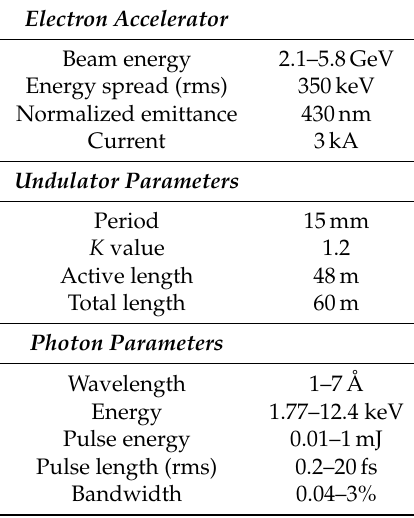
Table 1. SwissFEL hard X-ray Free Electron Laser (FEL) design